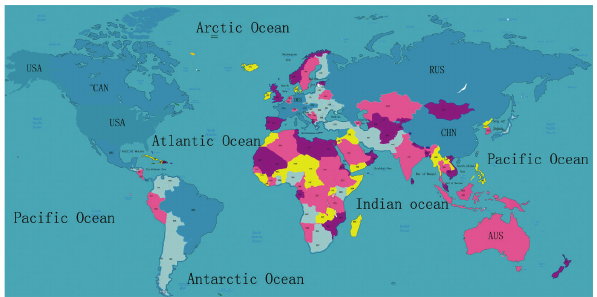
Figure 1: Illustration of the world map.